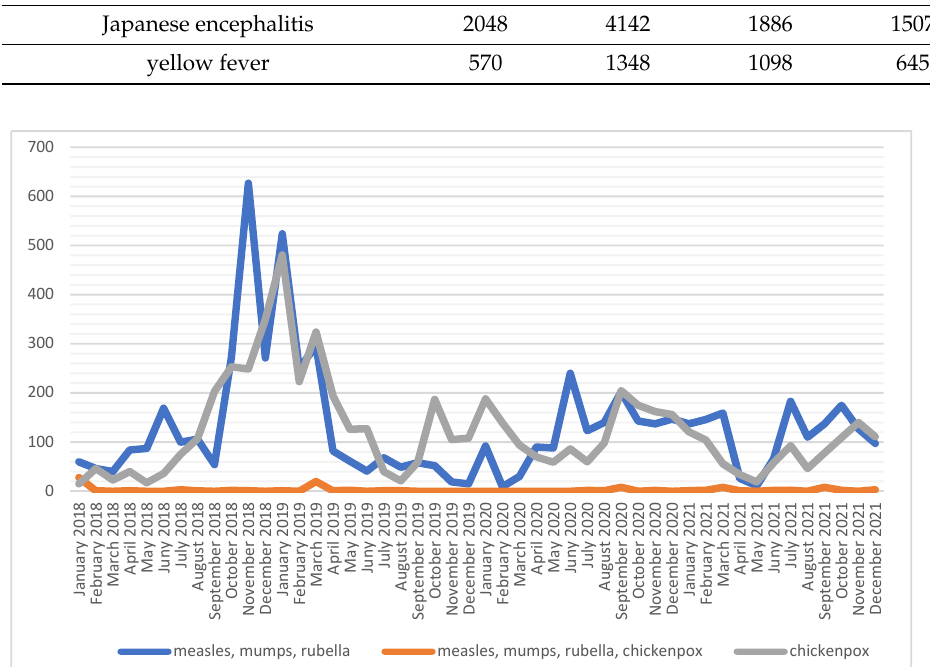
Figure 2. Number of vaccinations against diphtheria, tetanus, polio and typhoid fever among sol- diers in 2018–2021.